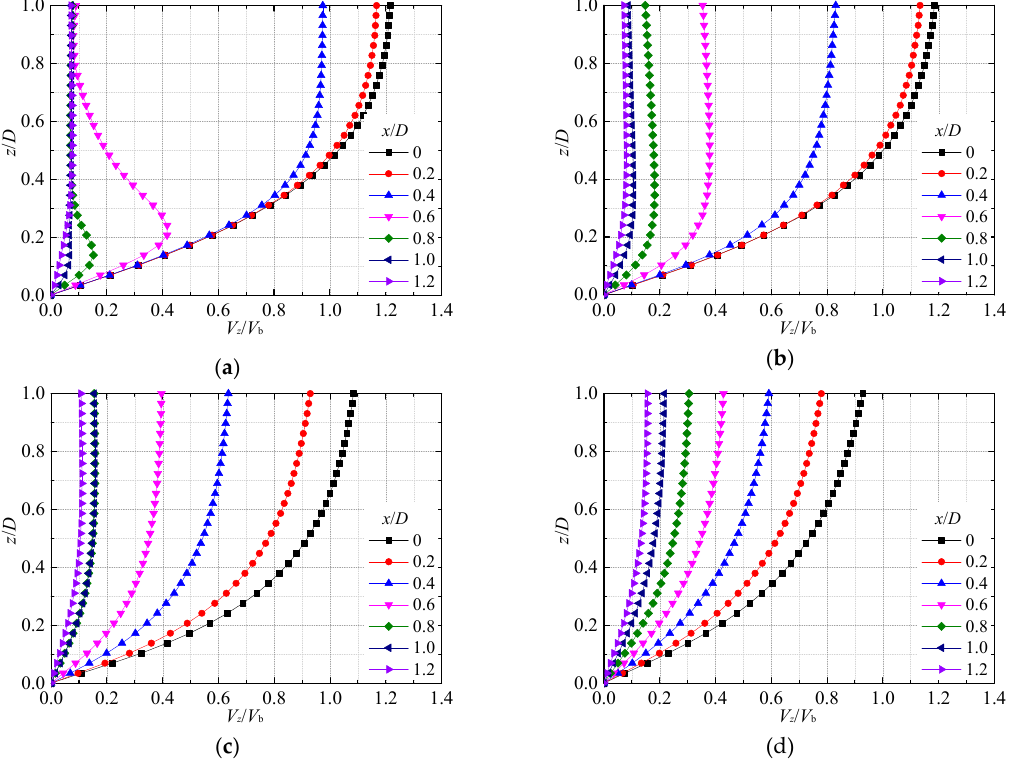
Figure 11. Development of mean vertical velocity ( V z / V b ) along the horizontal direction at di ff erent vertical locations on the near-wall region: ( a ) H / D = 1; ( b ) H / D = 3; ( c ) H / D = 6; ( d ) H / D = 8.